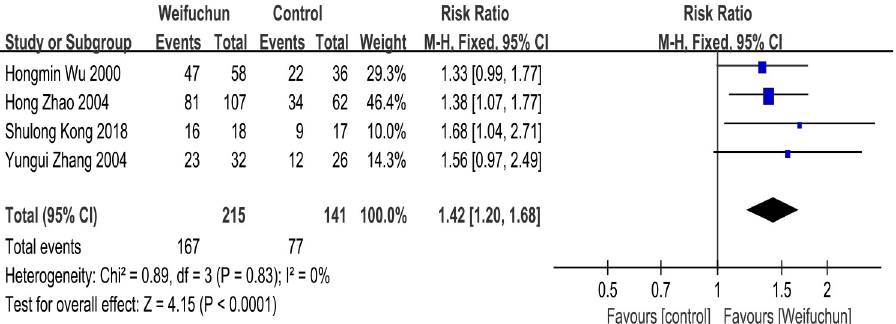
Fig 7. Forest plot of improvement of gastric mucosa under